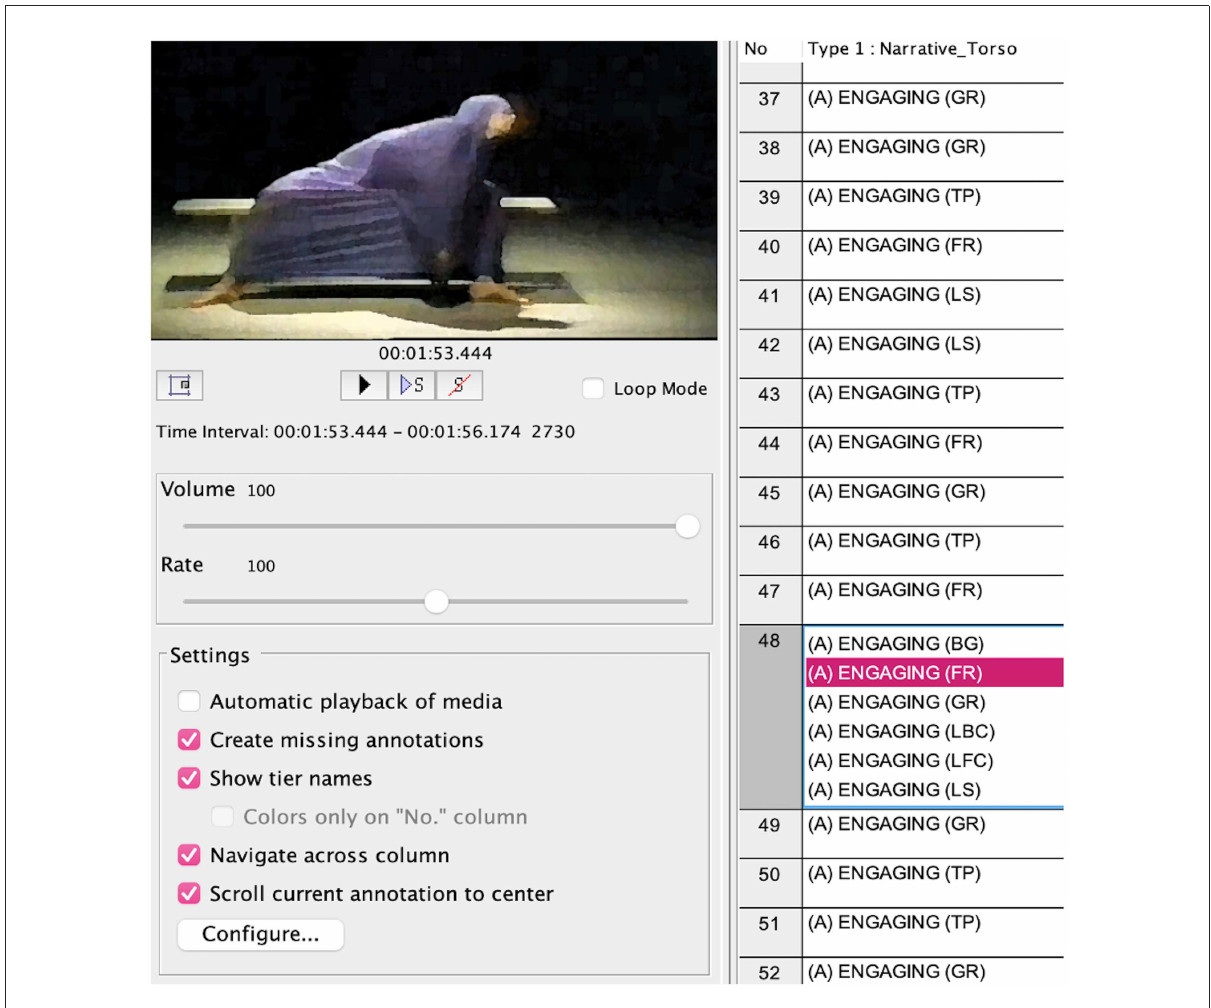
FIGURE8 ELAN’s Transcription working mode (showing move 47 and its default media